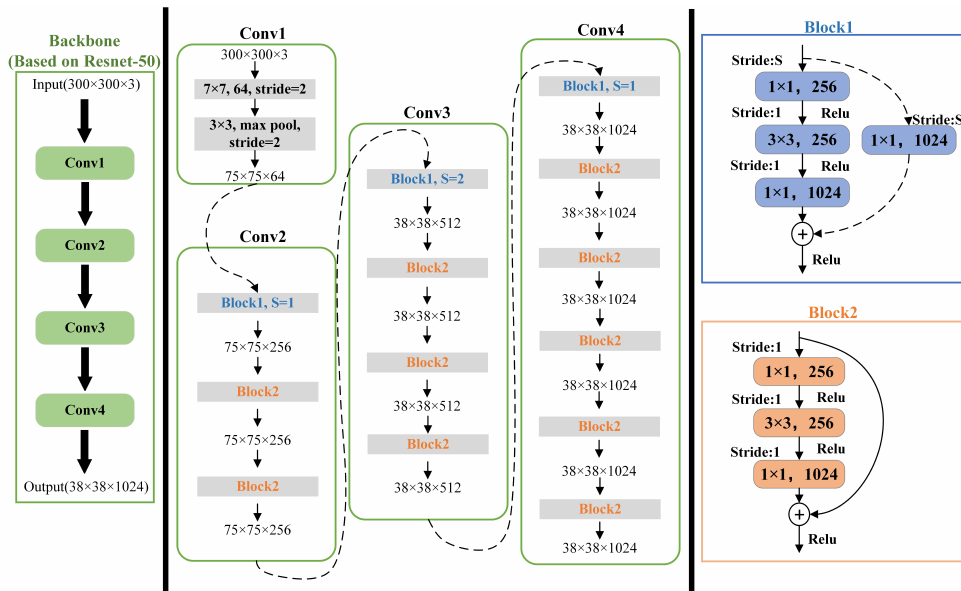
Figure 3. The structure of the backbone (based on Resnet-50) proposed in this